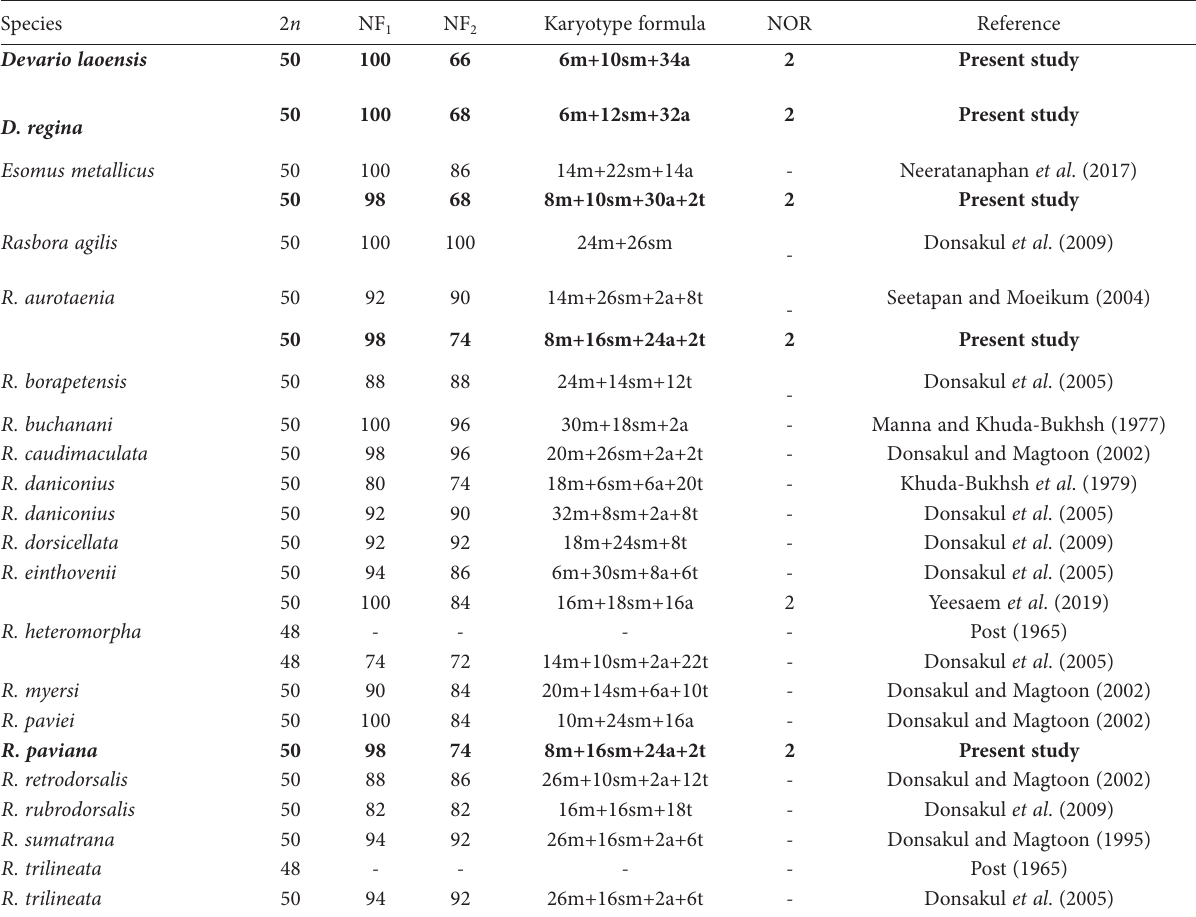
Table 2. Cytogenetic reported of the genera Devario , Esomus and Rasbora.